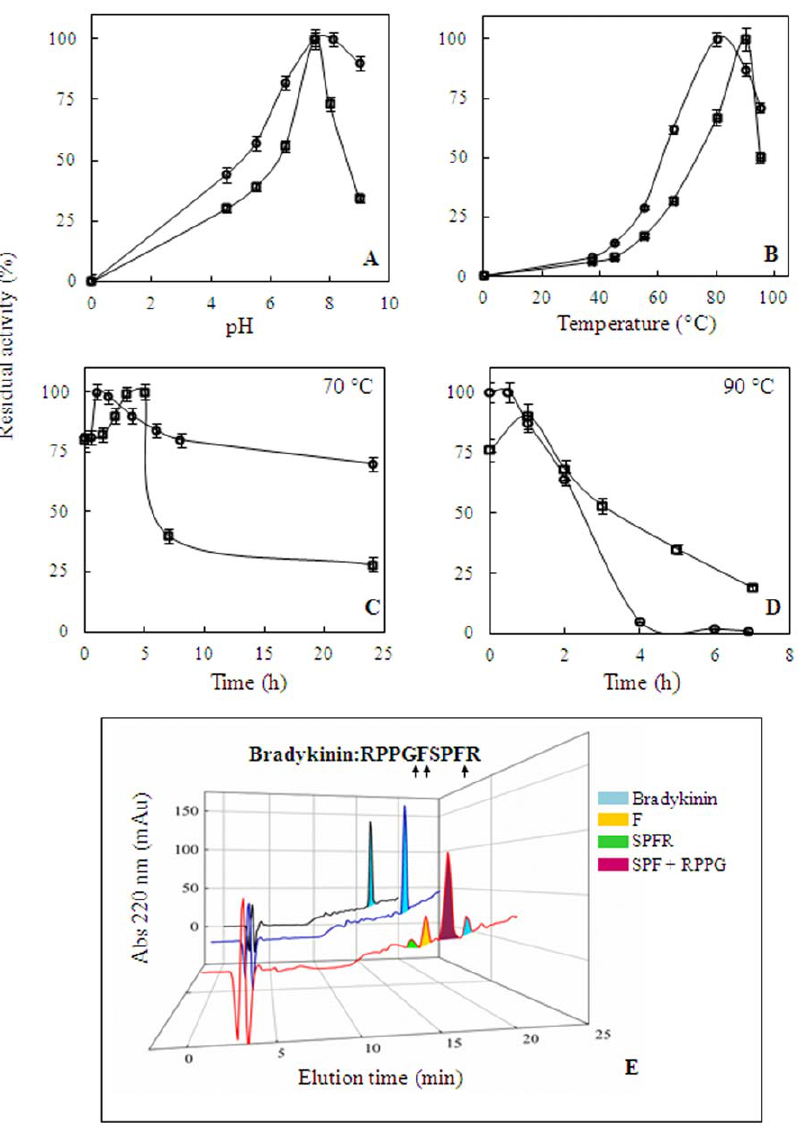
Figure 2. Functional and molecular properties comparison of APEH-3 Ss and APEH Ss . ( A ) pH-activity profile of APEH Ss and APEH-3 Ss . ( B ) Influence of temperature on the enzyme activities. ( C–D ) Thermoresistance of both APEH detected at ( C ) 70 u C and ( D ) 90 u C. In all pictures APEH Ss and APEH-3 Ss are indicated by a circle ( # ) or square ( % ) respectively. ( E ) RP-HPLC analysis of proteolytic digests of bradykinin with APEH Ss ( ___ ) or APEH-3 Ss ( ___ ). Control sample ( ___ ) was run in parallel in the absence of the enzymes and the chromatogram traces are shown. Colored peaks isolated after 30 min of incubation were collected and the identification of the peptides generated was performed by Edman degradation analysis. The enzyme cleavage specificity, revealed by the peptide fragments assigned along the bradykinin sequence, is indicated by arrows.